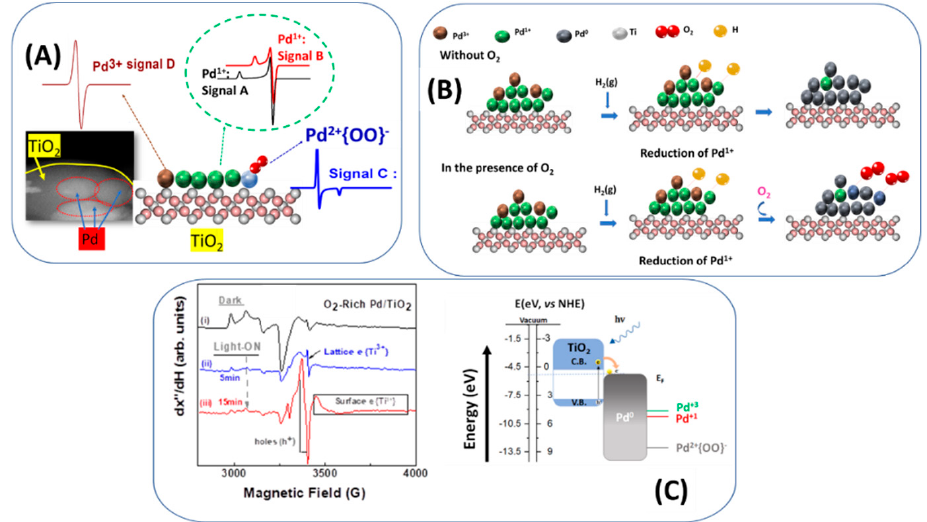
Figure 7. ( A ) Schematic depiction of structural assignment of the detected Pd n+ species. ( B ) Proposed mechanism of formation of {Pd 2+ -O 2 − } species ( C ) Schematic photoinduced electron transfer mecha- nism under photocatalytic conditions. (i–iii) materials with different treatment. Adapted from [25] with permission.